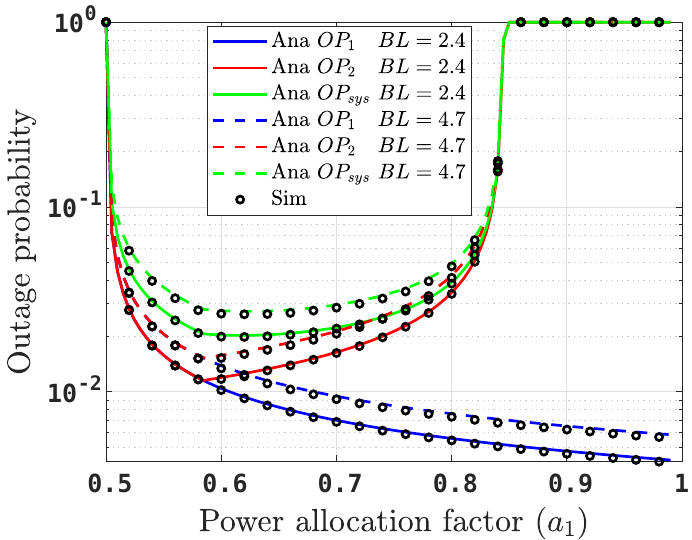
Figure 6. OPs over the entire range of power allocation factor at SNR = 40